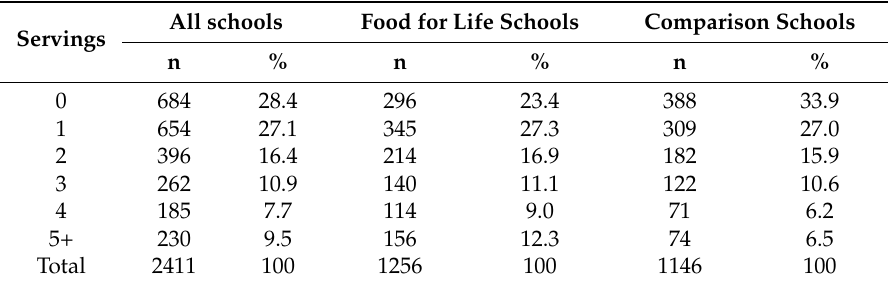
Table 5. Servings of fruit and vegetables consumed by